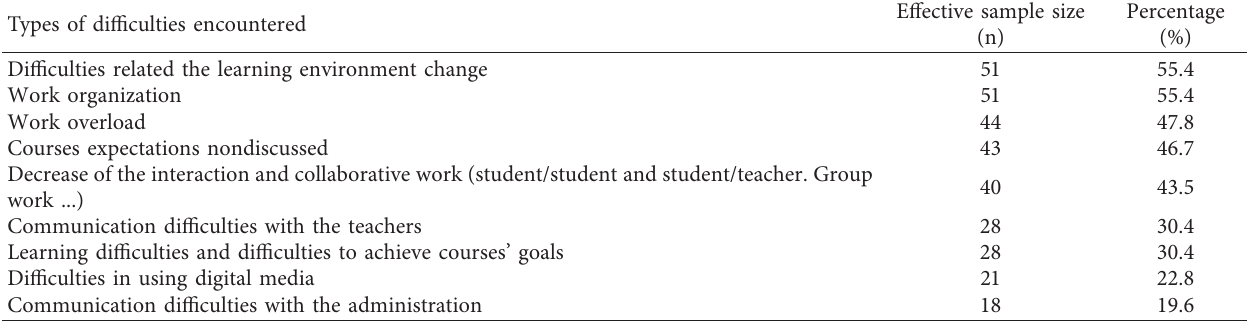
Table 3: The difficulties encountered by the students during the distance learning in the time of the